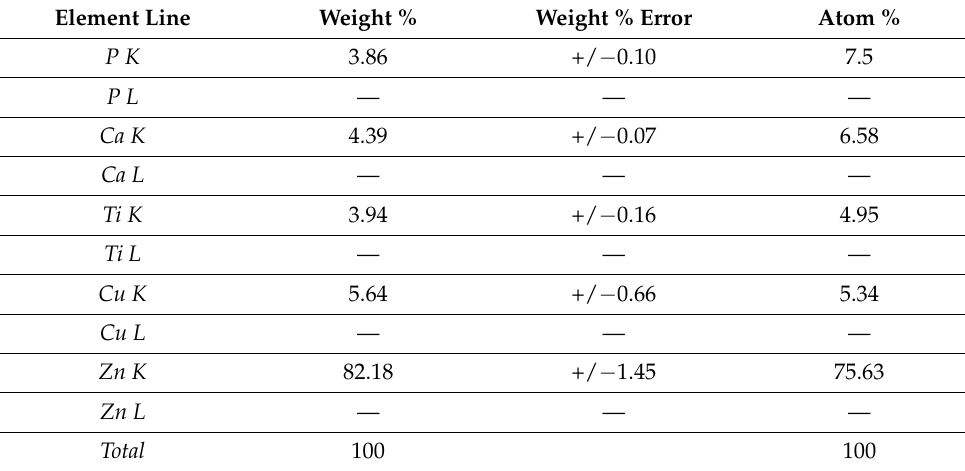
Table 2. Chemical composition of Zn-Ti-Cu-Ca-P alloy by EDS.